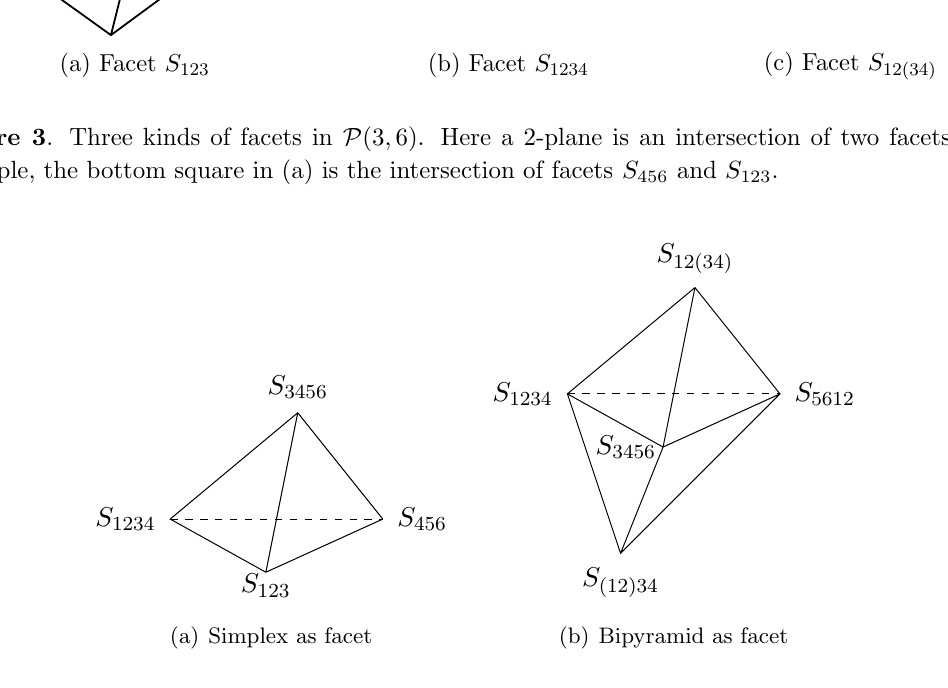
Figure 4 . Two examples of facets of the dual polytope P (cid:14) (3 ;